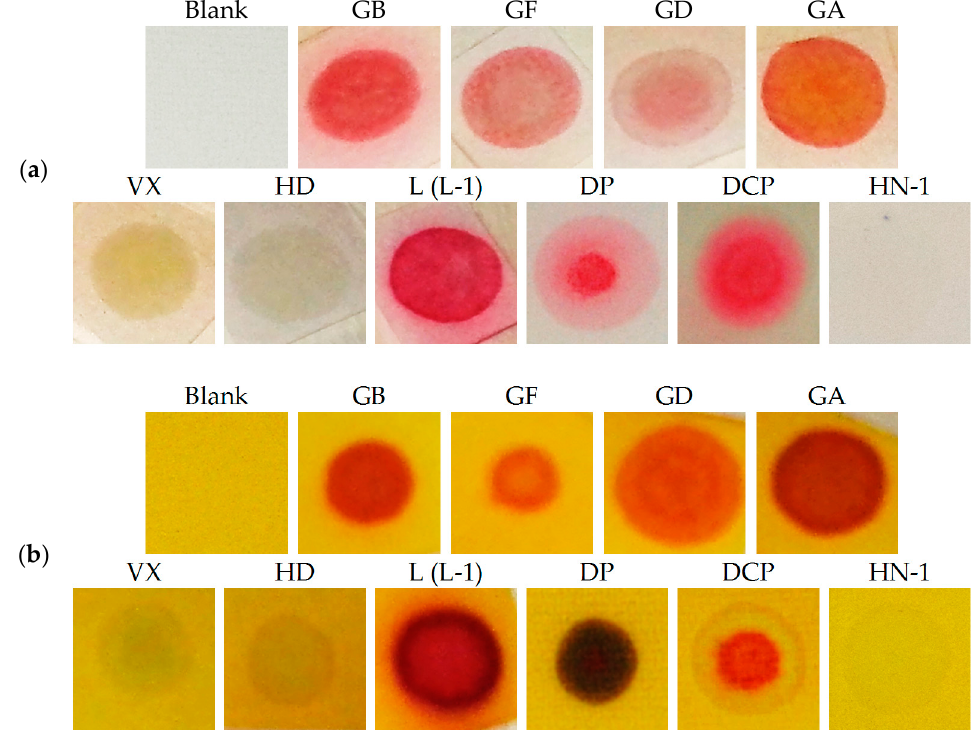
Figure 5. RM1a ( a ) and RM1a/PY-OPD ( b ) detection paper after the exposure to a droplet of CWA.